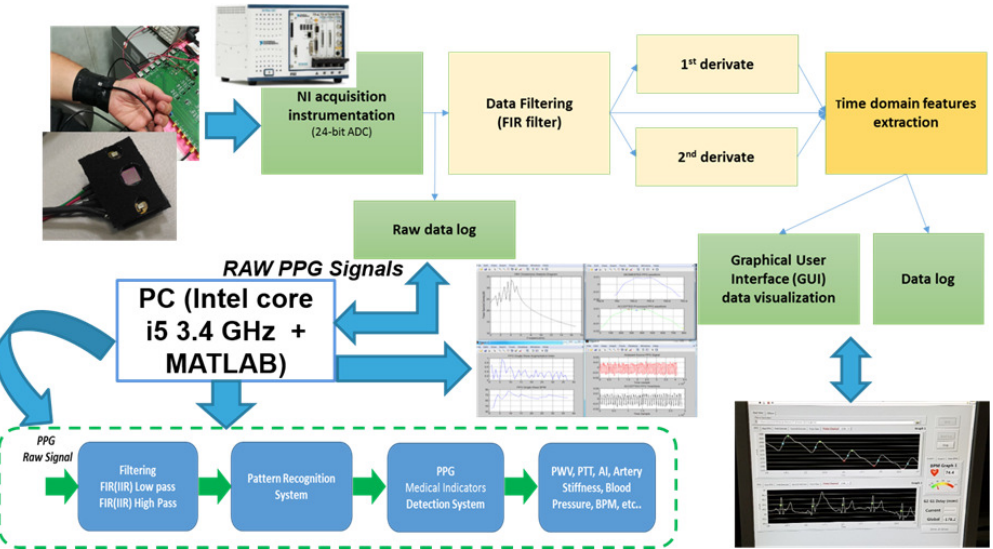
Figure 3. Detailed description of the whole PPG signal sampling system and pattern recognition pipeline. PTT, Pulse Transmit